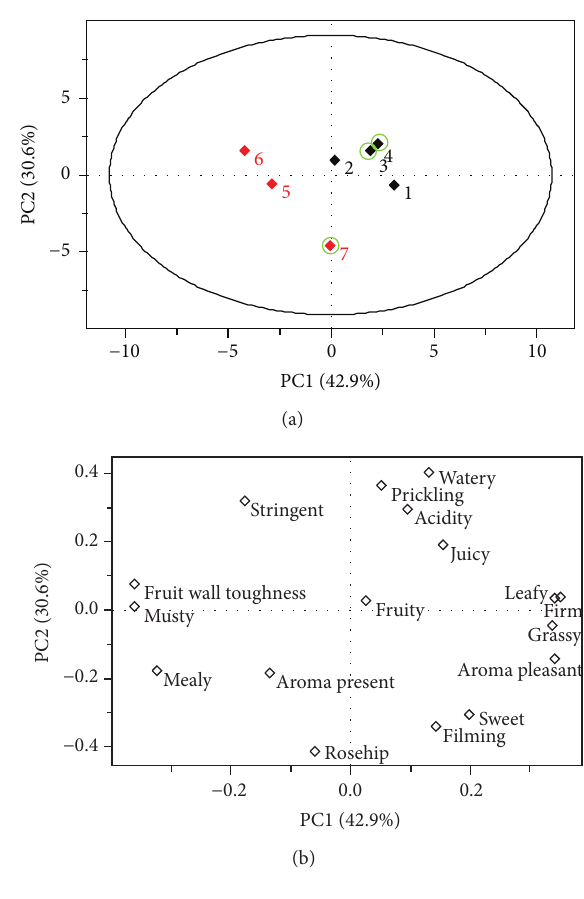
Figure4: Scores (a)andloadings (b)plot ofthefirsttwodimensions of the Principal Component Analysis of the autoscaled sensory data of the 2012 tomato samples from the Basilicata region (black symbols) and the Emilia Romagna region (red symbols). Green circles in the scores plot indicate organic